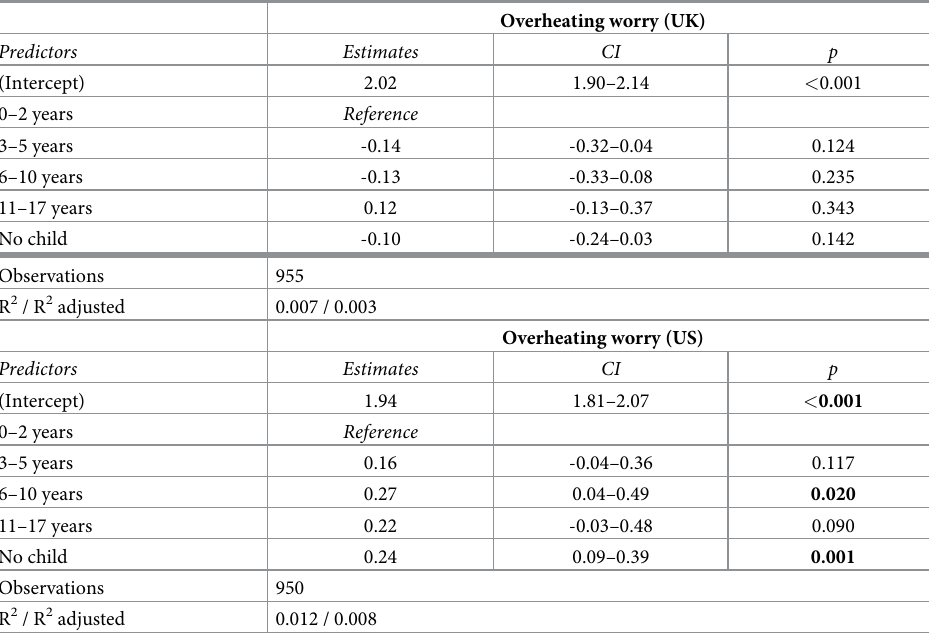
Table 2. Relating overheating worry to age of youngest child. a) Regression results using UK sample (0–2 years ref- erence category). b) Regression results using US sample (0–2 years reference